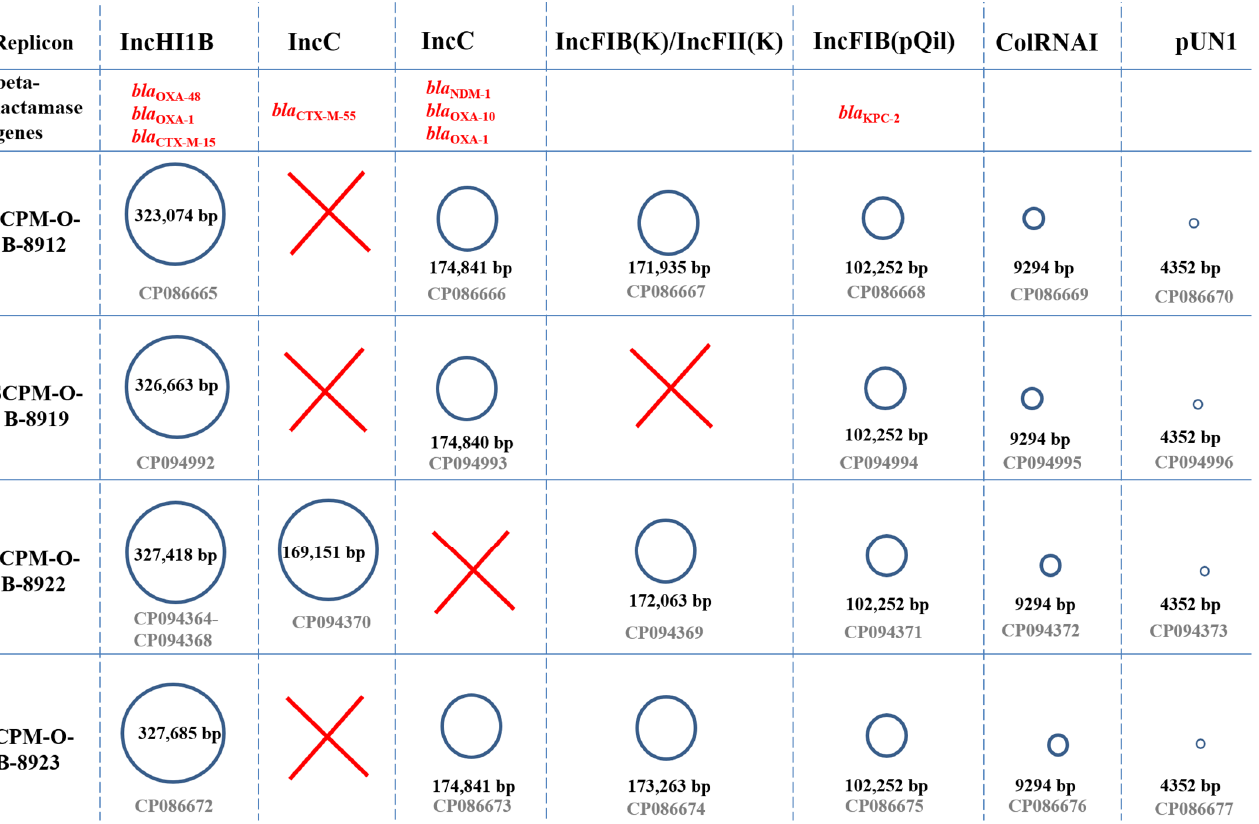
Figure 1. Plasmids identified in K. pneumoniae strains SCPM-O- B -8912, SCPM-O-B-8919, SCPM-O- B-8922, and